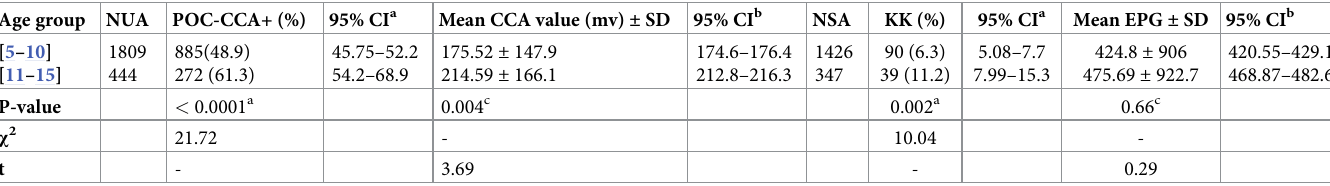
Table 4. Prevalence and infection intensity of S . mansoni infections according to age